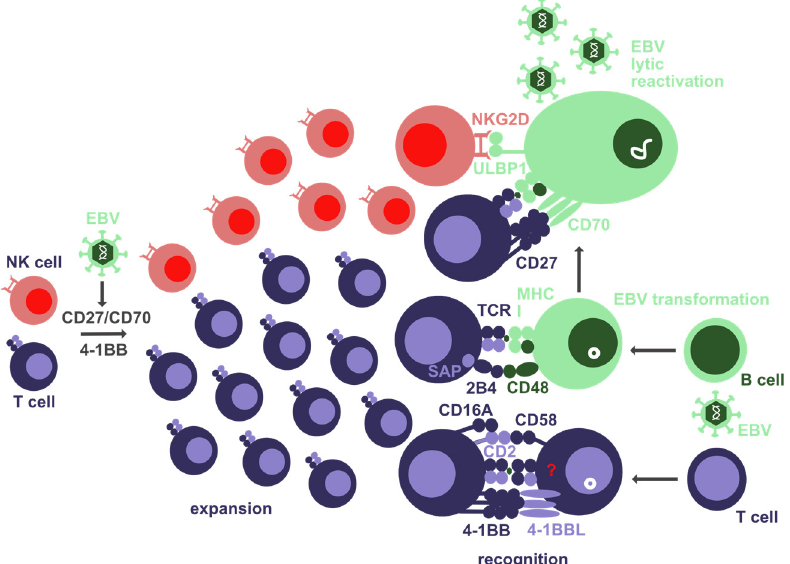
Figure 1. Co-stimulatory molecules that are involved in T and NK cell expansion as well as EBV- infected target cell recognition by these cytotoxic lymphocytes. The interaction of CD27 with CD70 as well as 4-1BB seems to be involved in T-cell expansion after EBV infection. SAP-associated SLAM receptors, such as 2B4, contribute to T-cell recognition of EBV-transformed B cells. CD27 and NKG2D are involved in T and NK cell recognition of lytically EBV-infected B cells, respectively. 4-1BB and CD2 (assisted by CD16A) might be involved in EBV-infected T-cell recognition.